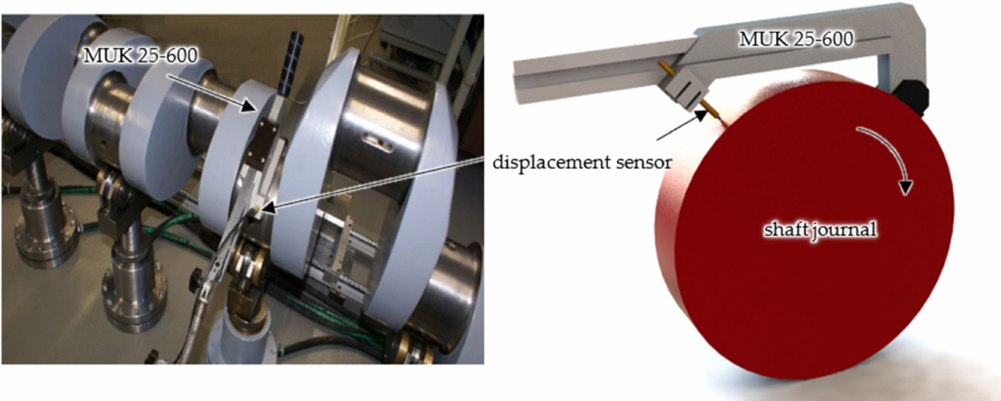
Figure 14. SAJD measurement system. This profile was evenly distributed over a length of 471 mm, which corresponded to the circumference of a wheel with the nominal diameter of 150 mm for the measured main journal (Figure